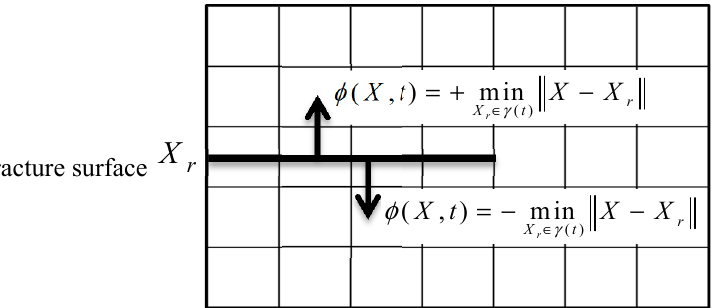
Figure 2. Schematic diagram of fracture surface simulation and level set function on the calculation point.